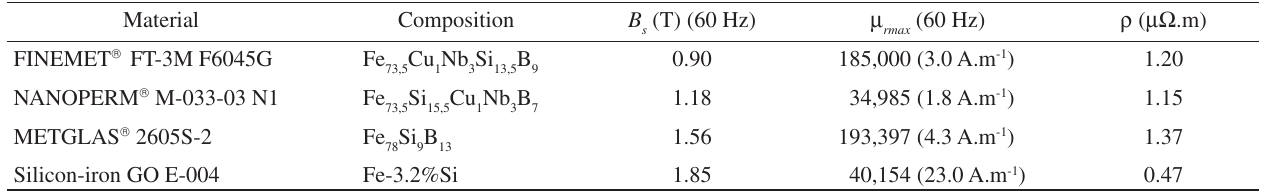
Table 1. Magnetic materials simulated as CT cores. Material